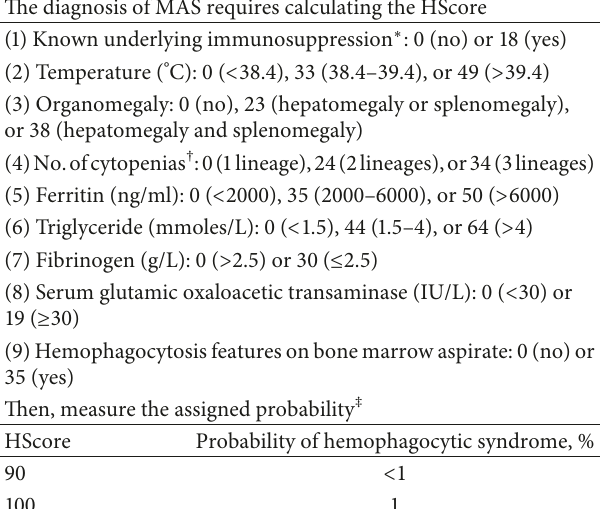
Table 3: Diagnostic criteria for macrophage activation syndrome: the